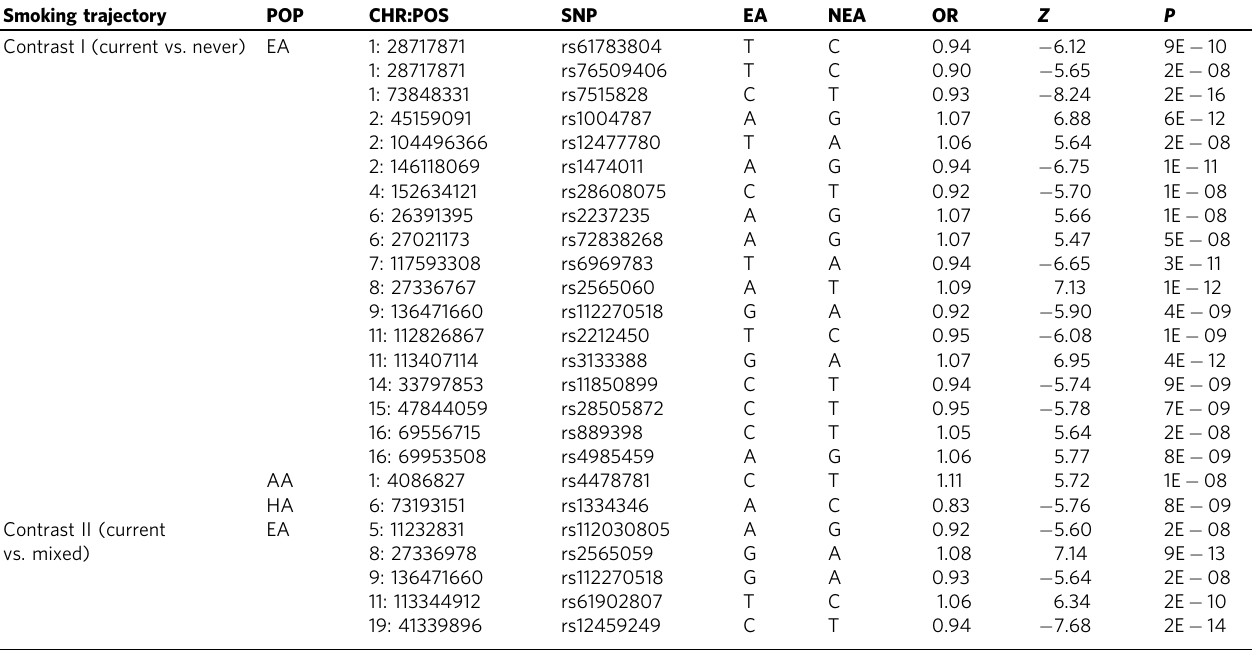
Table 2 Genome-wide signi fi cant associations for smoking trajectories in the Million Veteran Program ( N = 286,118). Smoking trajectory POP CHR:POS SNP EA NEA OR Z P Contrast I (current vs. never) EA 1: 28717871